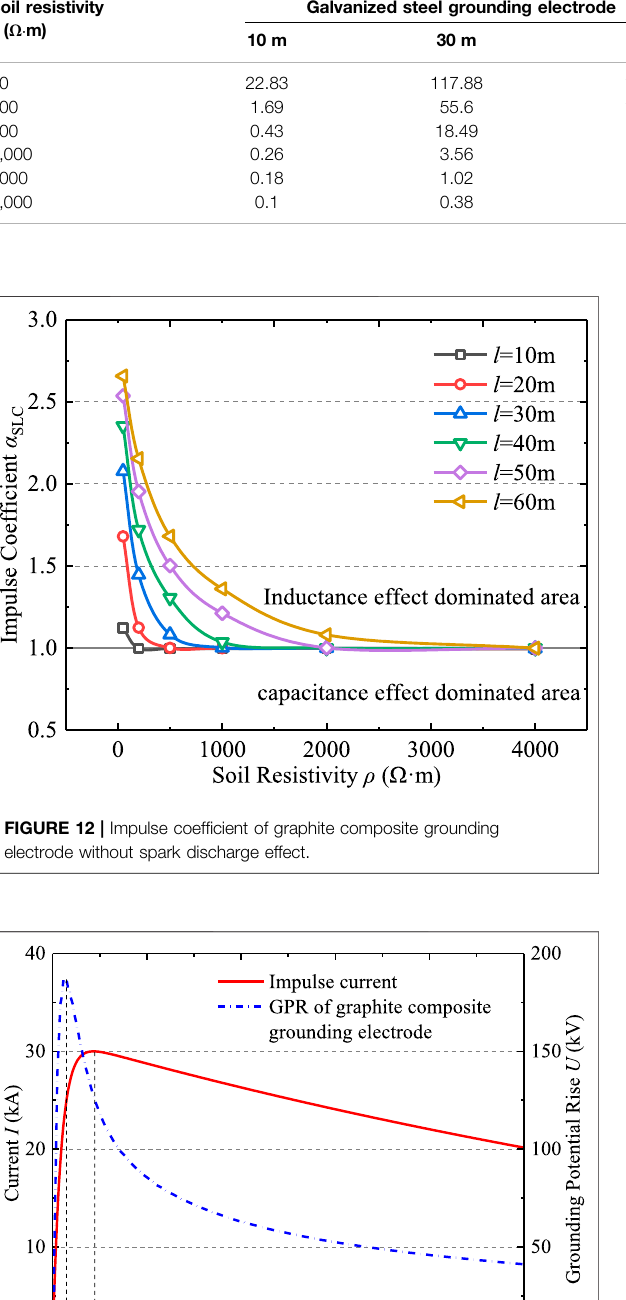
Frontiers in Energy Research |